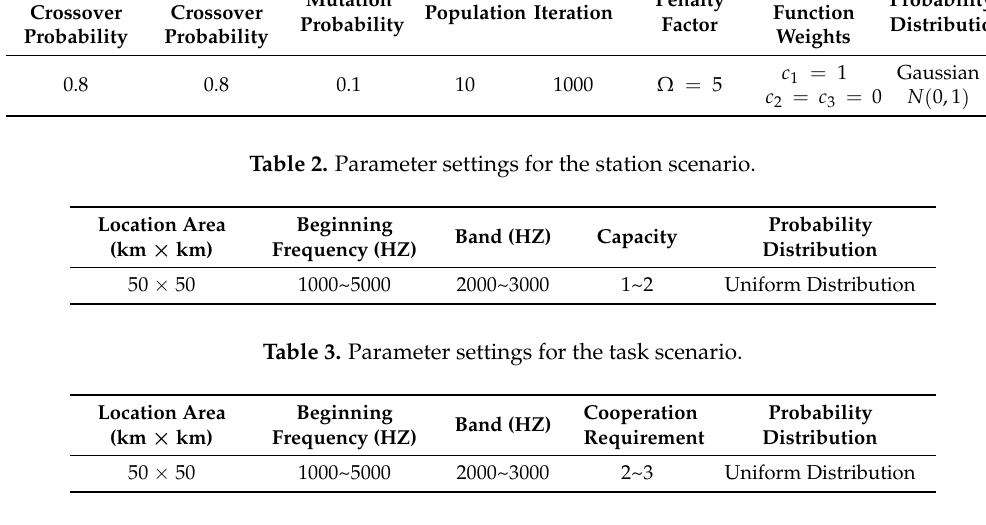
Table 1. Parameter settings for the algorithm.